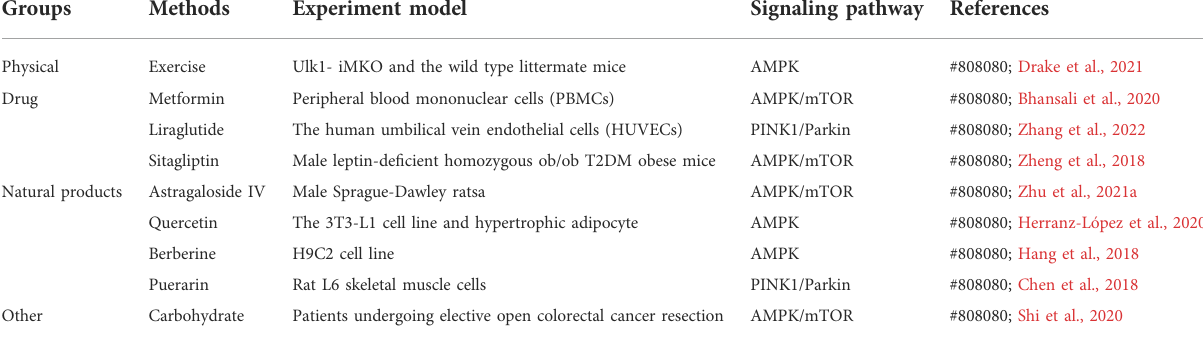
TABLE 1 Models and signaling pathways of factors in fl uencing in